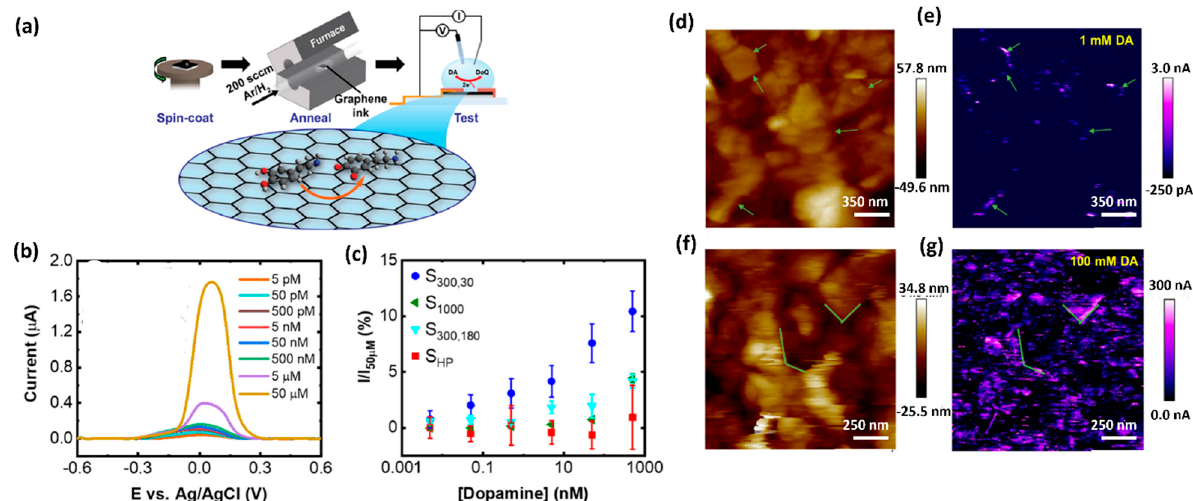
Figure 2. ( a ) Schematic representation of fabrication and electrochemical testing process of the graphene ink-based DA sensor. ( b ) Differential pulse voltammogram of the response towards DA detection from 5 pM to 50 μ M. ( c ) Normalized peak current values versus DA concentration. ( d ) Height map, measured using scanning electrochemical microscopy (SECM) and ( e ) the corresponding electrochemical map with 1 mMDA. ( f ) A height map of a different region of the graphene film and ( g ) the corresponding electrochemical map with 100 mM DA [22].